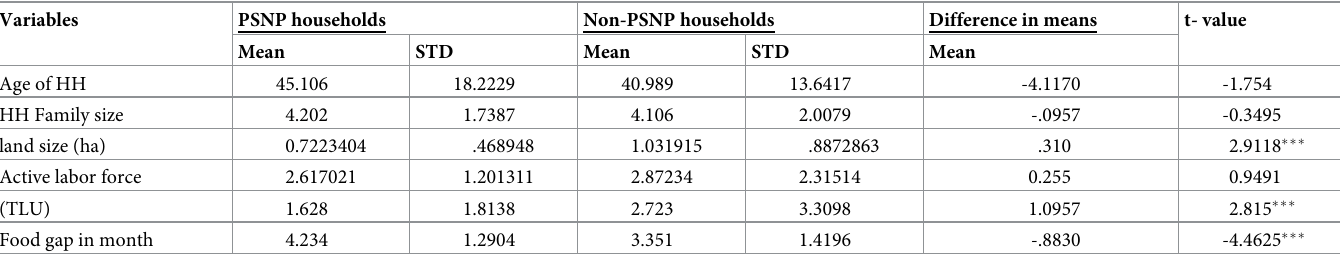
Table 2. Summarized descriptive statistics of sample households.